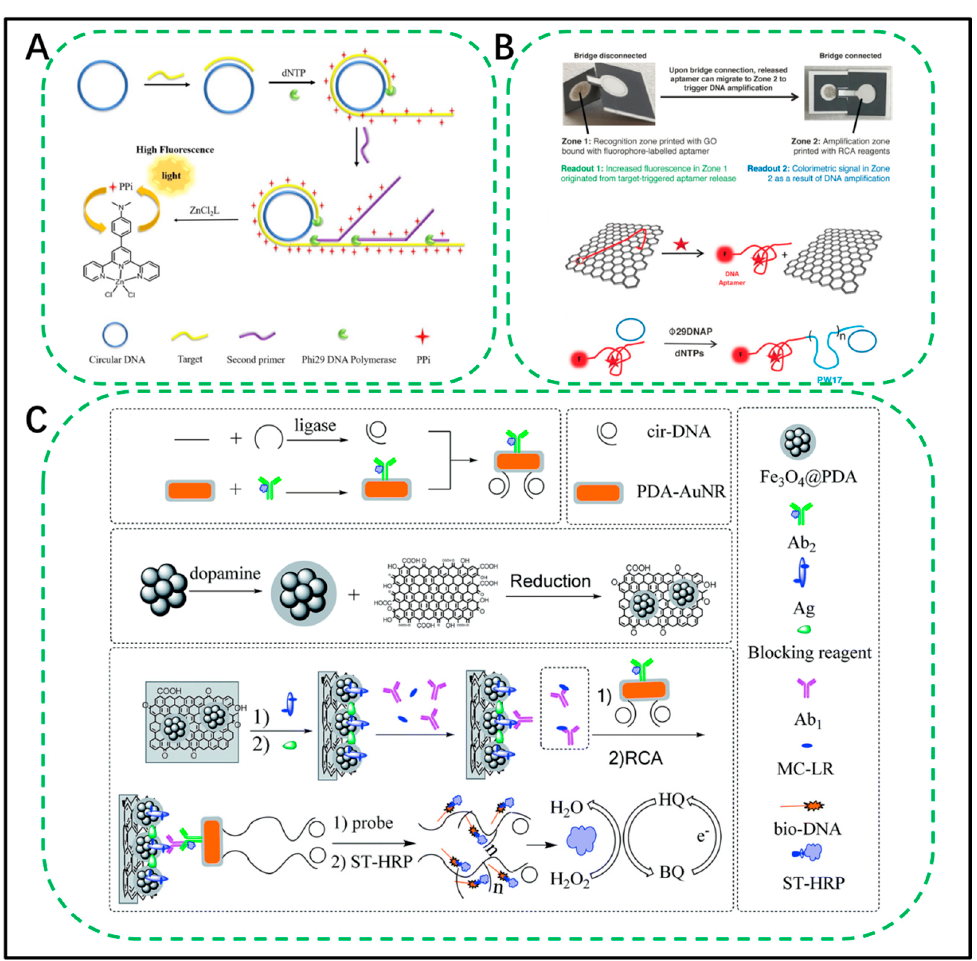
Figure 5. RCA assay for nucleic acid detection. Adapted with permission from ref. [84,88,89]. ( A ) Label-free miRNA sensor based on zinc terpyridine complex; ( B ) design of detachable paper-based biosensor with dual signal output; ( C ) construction of a dual-signal amplification immunosensing platform based on magnetic graphene. MC-LR: microcystin-leucine-arginine, PDA: polydopamine, Ab1: antigen (Ag) and antibody (primary antibody), ST-HR: